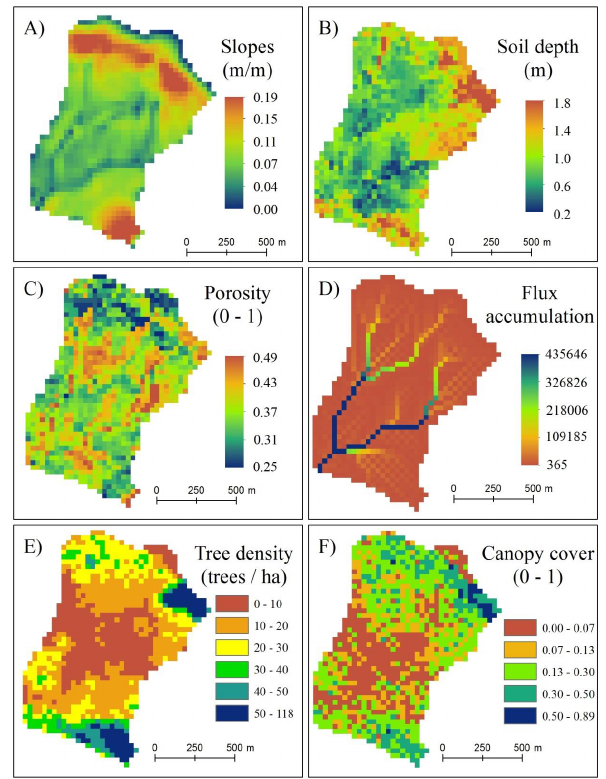
Figure 2. Maps of catchment properties: A) slope ( m/m ), B) soil depth ( m ), C) porosity (0–1), D) flux accumulation (number of pixels that spill on another), E) tree density ( trees ha -1 ), F) tree canopy cover (0–1). Maps were obtained as described in Maneta et al. (2008).